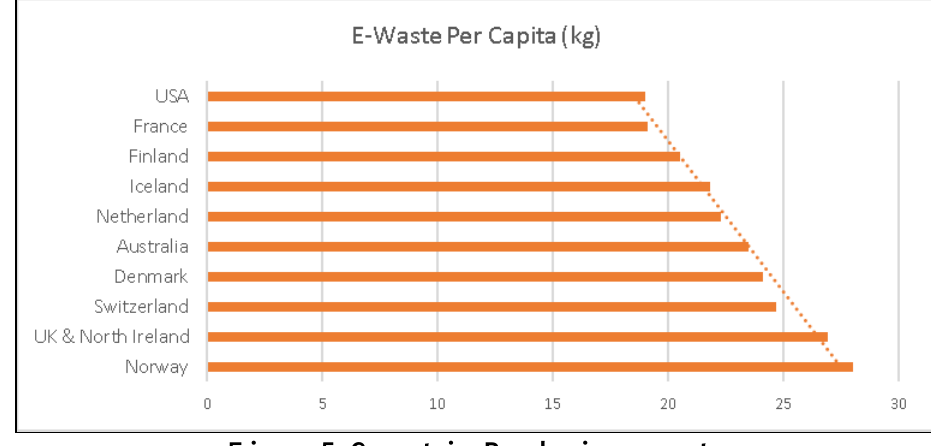
Figure.5. Countries Producing e-waste Source: (Herat & Agamuthu, 2012)